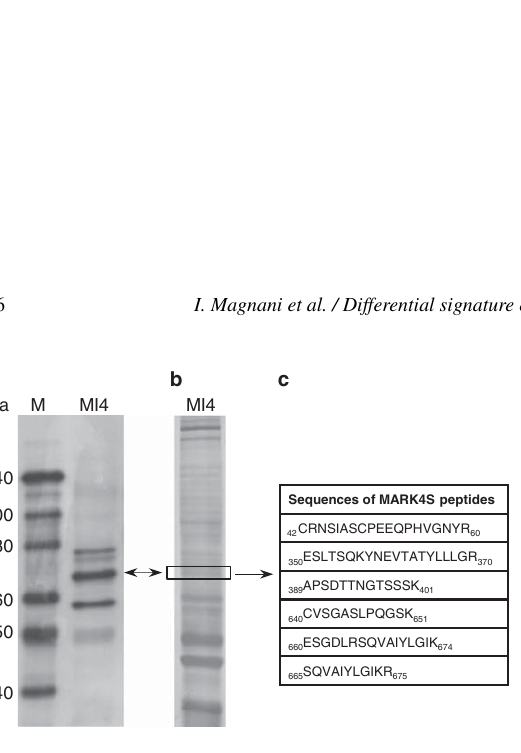
Supplementary Figure 2. Mass spectrometric identification of the band corresponding to MARK4S protein in MI-4 whole cell lysate. (A) Arrows indicate the band, detected by the anti-MARK4S anti- body from Abcam, corresponding to MARK4S protein. (B) The matching silver-stained band was excised and analysed by mass spectrometry. (C) Sequences of MARK4S peptides found in the indicated band; the first three sequences are shared by both MARK4 isoforms (amino acids 1–625), whereas the last three are specific to the S isoform (amino acids 626-688). M, molecular weight ladders (kDa).